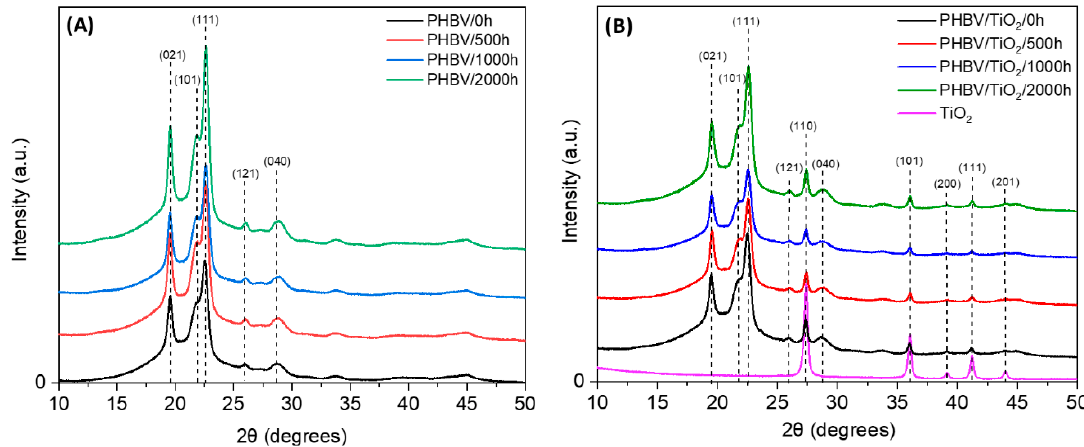
Figure 3. XRD spectra of ( A ) the neat PHBV and ( B ) the PHBV / TiO 2 nanocomposites at di ff erent accelerated weathering